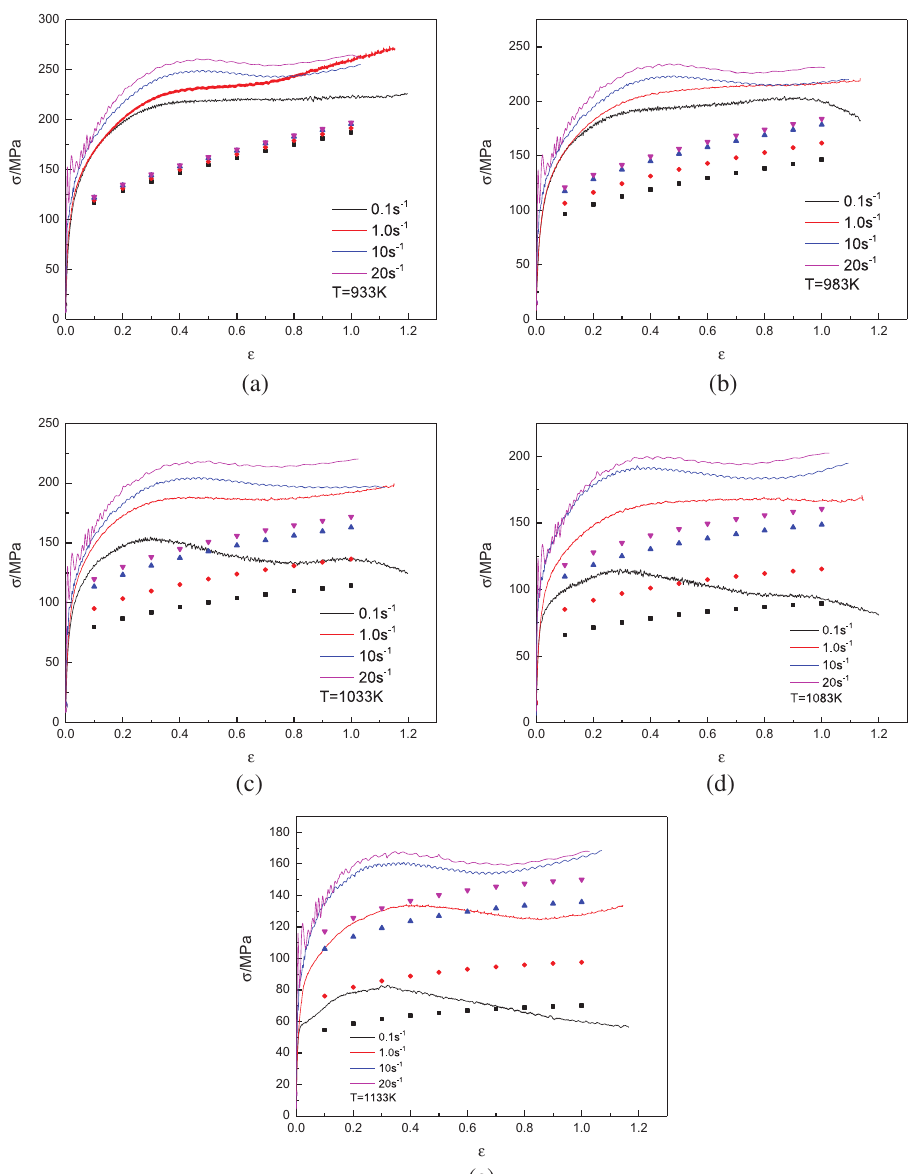
Figure 15: Comparison between experimental and predicted flow stress using modified ZA model at the temperatures of (a) 933 K, (b) 983 K, (c) 1,033 K, (d) 1,083 K, (e) 1,133